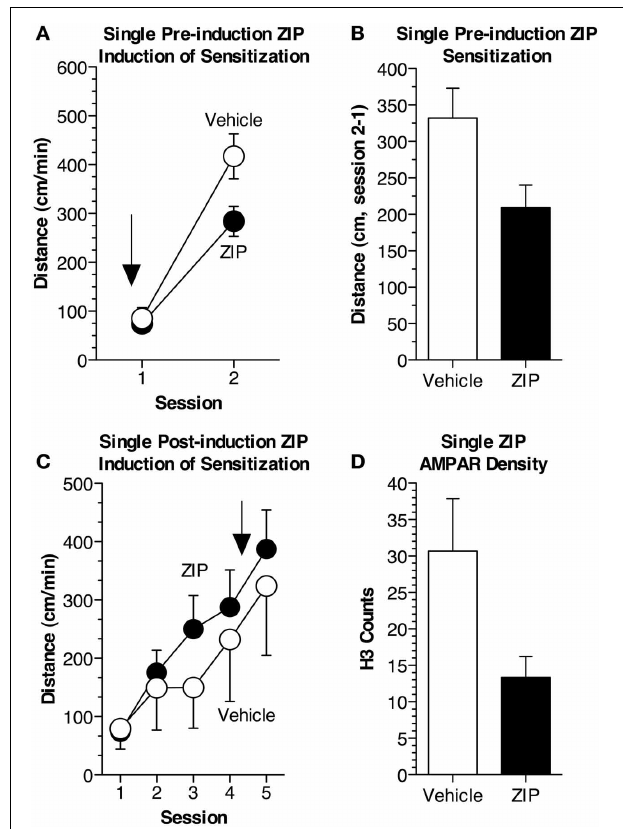
FIGURE 3 | Single pre- but not post-induction application of ZIP reduces locomotor sensitization. (A) Mice received a single pre-induction infusion of ZIP (10nmol/ μ L, 1 μ L). Sensitization was induced during two sessions of cocaine administration (15mg/kg, i.p.). ZIP was administered 2h prior to the first cocaine administration session ( n = 13 ZIP, n = 13 aCSF), indicated by the arrow. The average distance traveled ( ± s.e.m.) for each session is shown. While on-ZIP, the acute response to cocaine was not altered [ANOVA, F ( 1 , 24 ) = 0 . 215, p = 0 . 65]. Cocaine was given for a second time, 48h later, during session 2. When measured off-ZIP, distance traveled was significantly reduced in animals that had previously received ZIP [ANOVA, F ( 1 , 24 ) = 5 . 8, p < 0 . 05]. (B) Sensitization was significantly reduced in animals given ZIP prior to cocaine administration [ANOVA, F ( 1 , 24 ) = 5 . 7, p < 0 . 05]. Sensitization is represented as the average difference in distance traveled ( ± s.e.m.) between the two sessions.